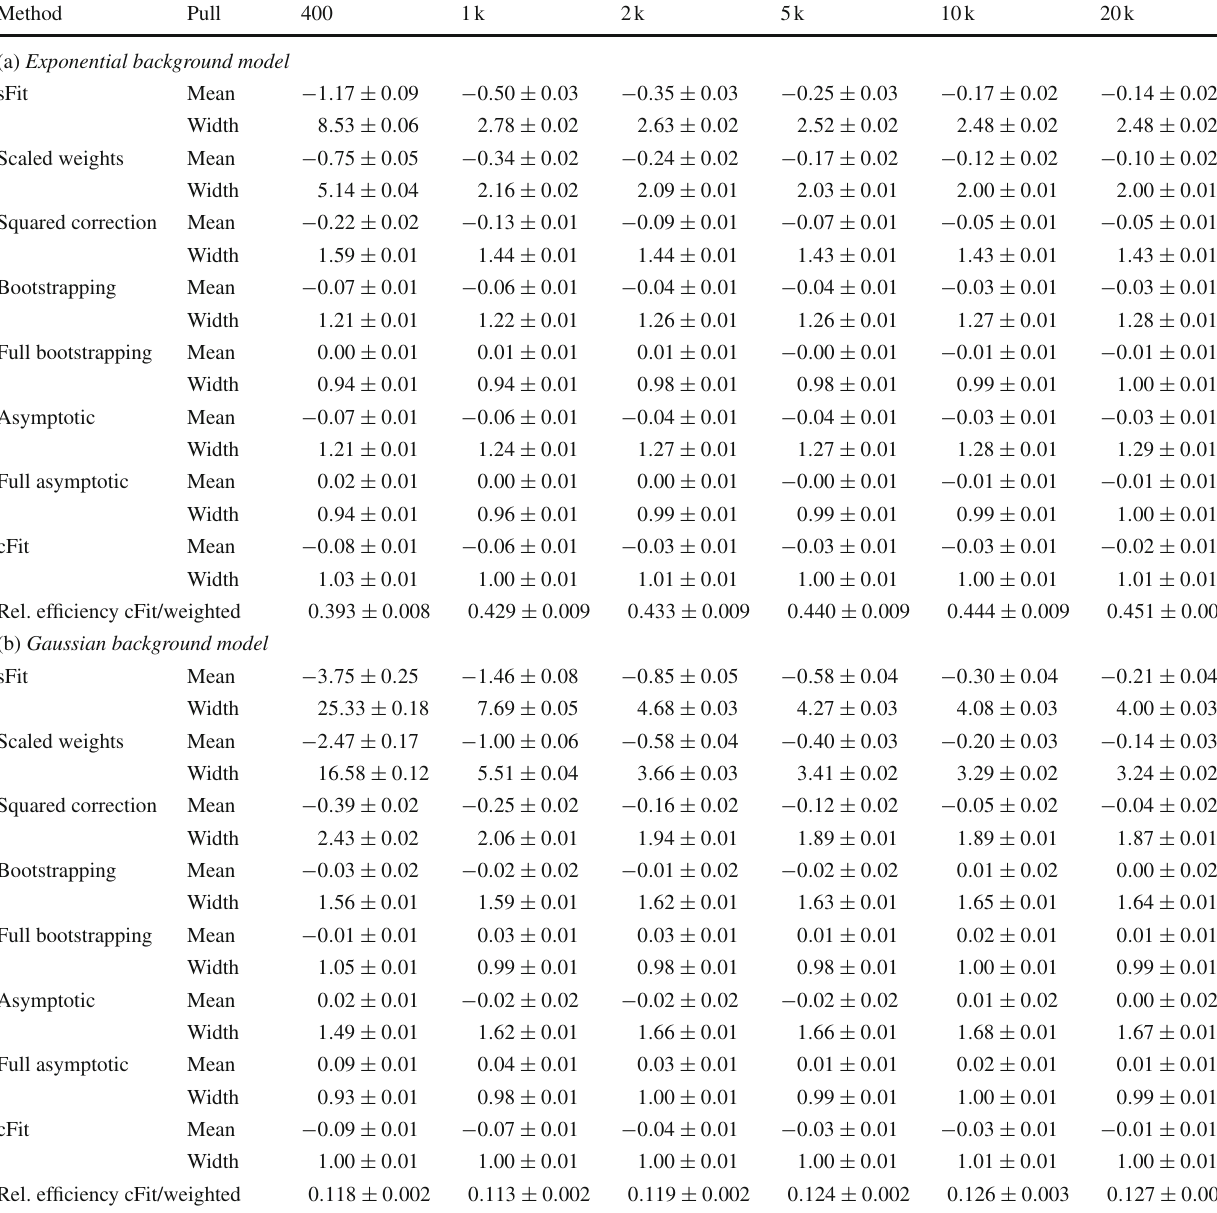
thecFitestimatorandtheweightedestimatordefinedbyEq. 3aregiven. Thedifferenttablesshowncorrespondtothedifferentbackgroundmod- els as specified in Sect.